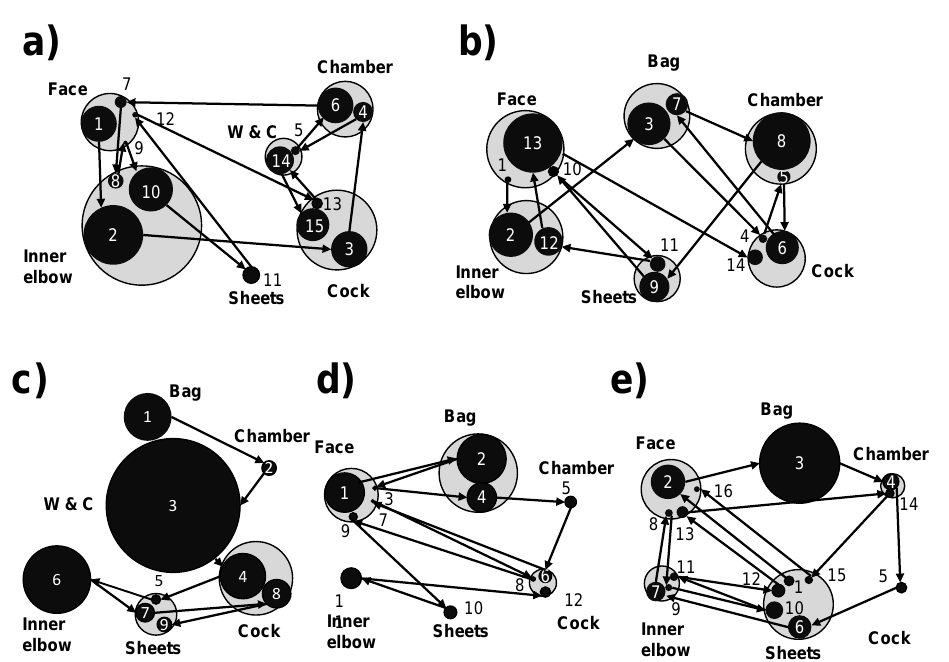
Figure 4. Gaze transition between the AOIs. The circles and arrows represent AOIs and transitions between pairs of AOIs, respectively. The numbers indicate the order of transition. The black and gray circles indicate the gaze duration corresponding to an AOI and the total gaze duration corresponding to an AOI, respectively. Panels ( a – e ) correspond to the data gathered from five participants, nurses 1 – 5. W & C denotes watch and chamber, respectively.